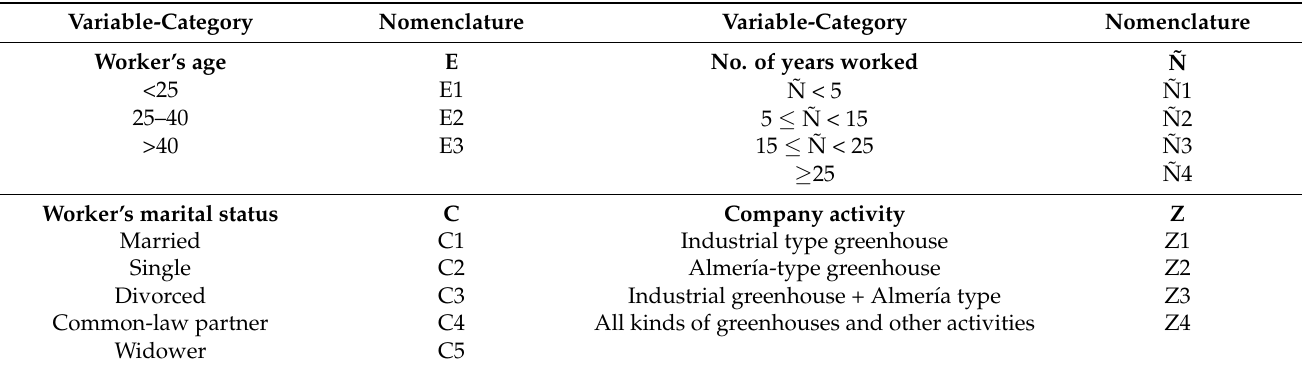
Table A4. Nomenclature for the general company categories and the worker variable categories used in the multiple correspondence